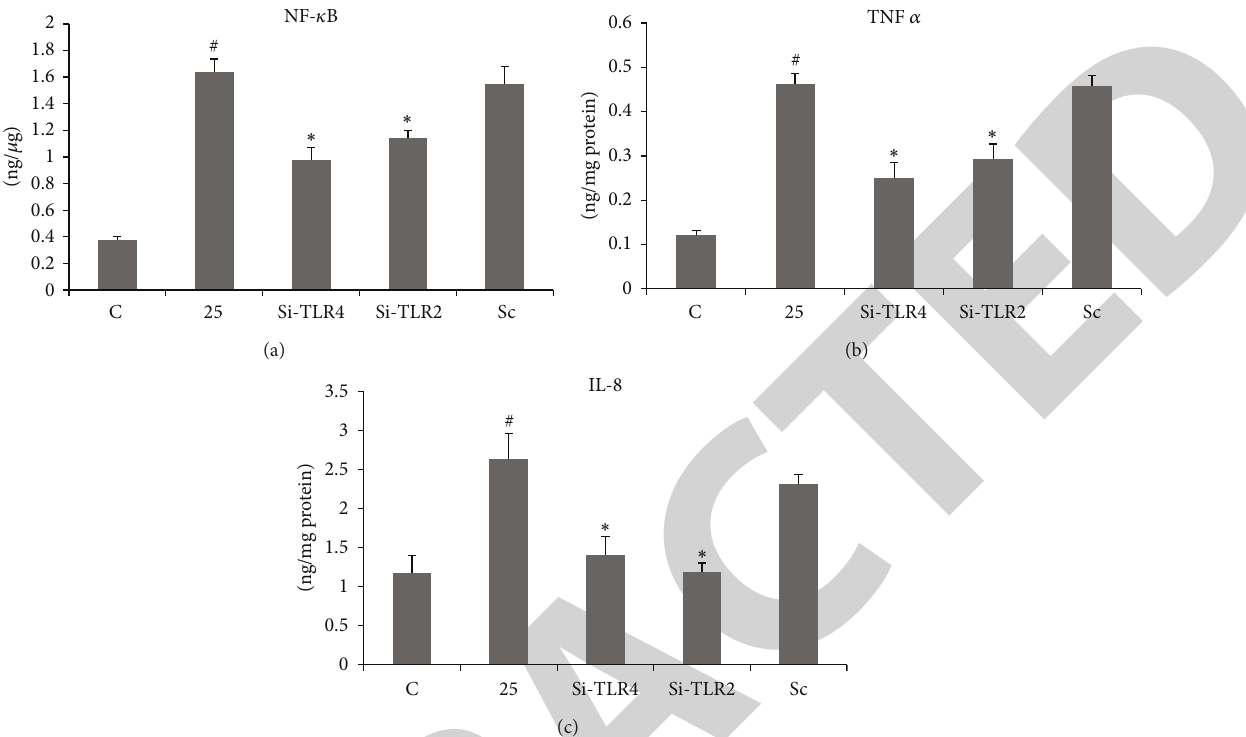
Figure 8: siRNA for TLR-2 and TLR-4 attenuates downstream inflammatory biomediators: HMVRECs treated with 0.75 𝜇 g siRNA for 18–24 hours in transfection media. The cells were replaced in complete media and allowed to settle for 24 hours. Subsequently cells were serum starved for 2 hours and HG treatments given as described inFigure 1 . (a) NF- 𝜅 B, (b) TNF- 𝛼 , and (c) IL-8. # 𝑃 < 0.001 versus control and ∗ 𝑃 < 0.001 versus 25 mM; Sc: scrambled sense